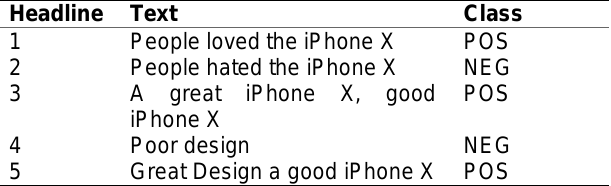
Table 1. Training data example for sentiment